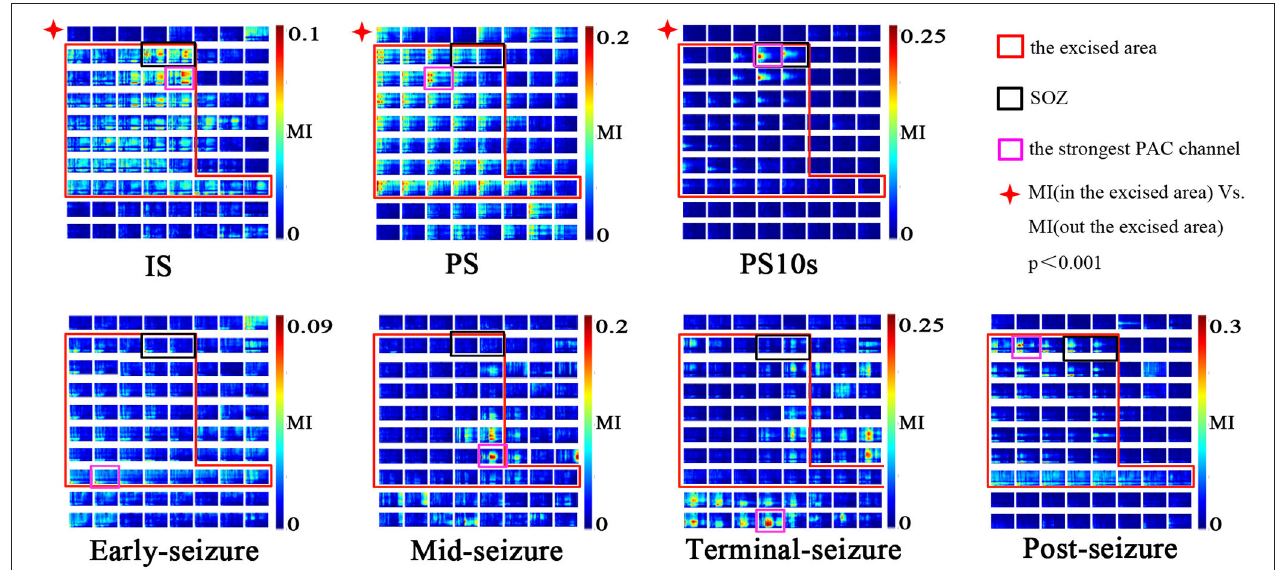
FIGURE 4 | Spatial specificity of PAC. Modulation was computed in 10-s windows at different seizure periods (IS, PS, PS10, early-seizure, mid-seizure, terminal-seizure, post-seizure). The MI co-modulograms of all channels were arranged in turn in each sub-figure. The scales were indicated by the color bar on the right side of the sub-figure. The red rectangle is the excised area; The black rectangles is SOZ; The purple rectangles is the strongest PAC channel. This figure shows that the strong PAC in the IS, PS, PS10 periods was more concentrated on the resection margin. Once seizure begined, the strong PAC gradually subsided from SOZ to surrounding general resection area, and gradually translocated to the unresection area. In the post-seizure period, the strong PAC channels returned to the resected area. During the IS and PS period, the strongest PAC channel was usually located in resection margin very near but not SOZ; in the PS 10 , it was often located in the SOZ.